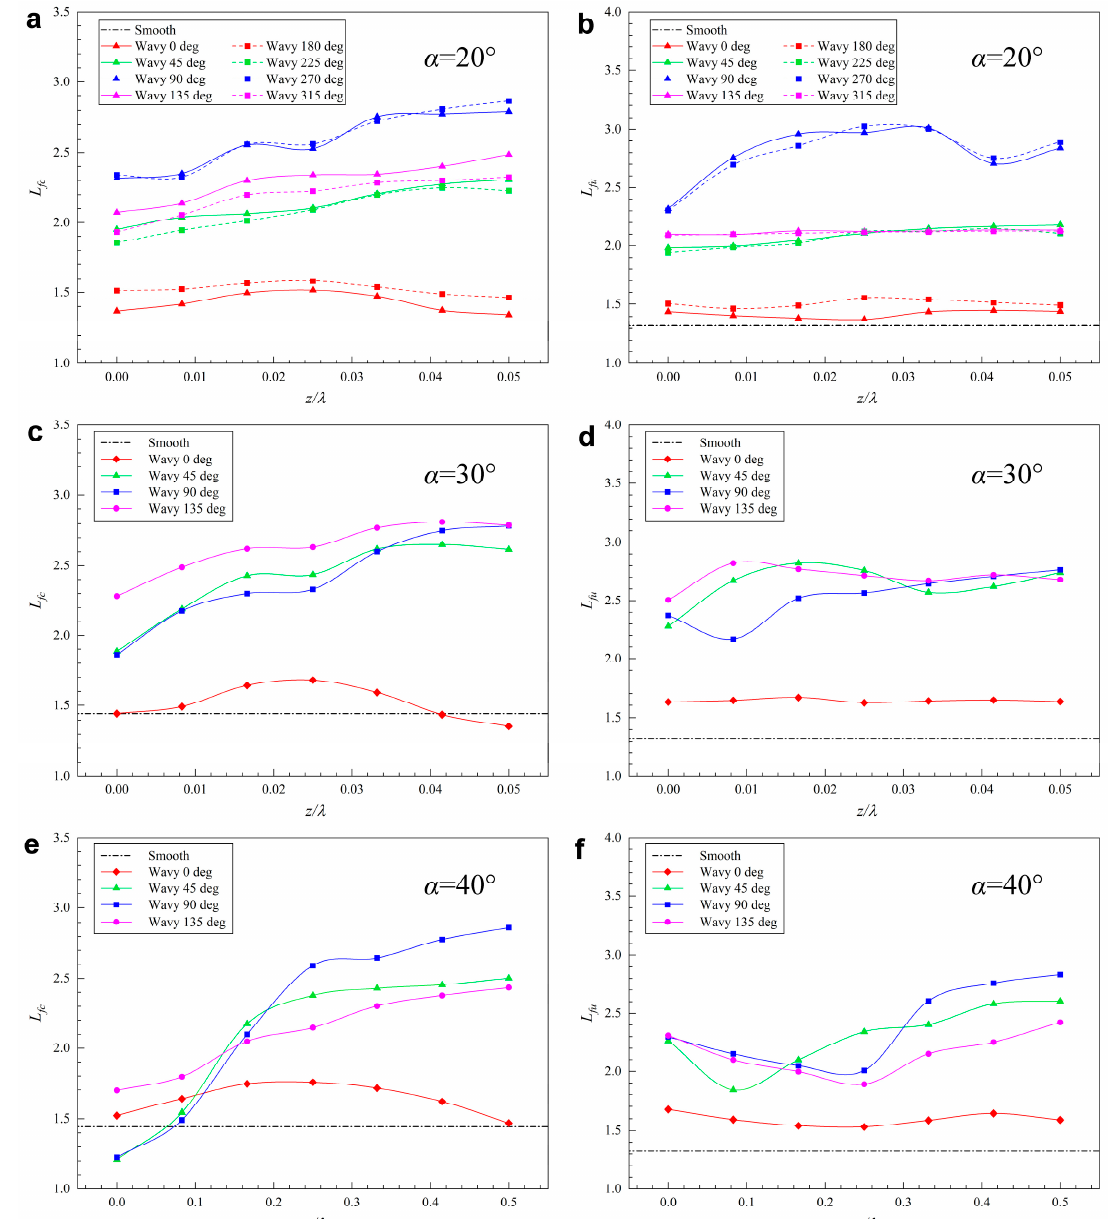
Figure 10. Two definitions of the vortex formation length, ( a , c , e ) the wake closure length ( L fc ) and ( b , d , f ) the maximum turbulence intensity length ( L fu ), for the smooth cylinder and three wavy cylinders.